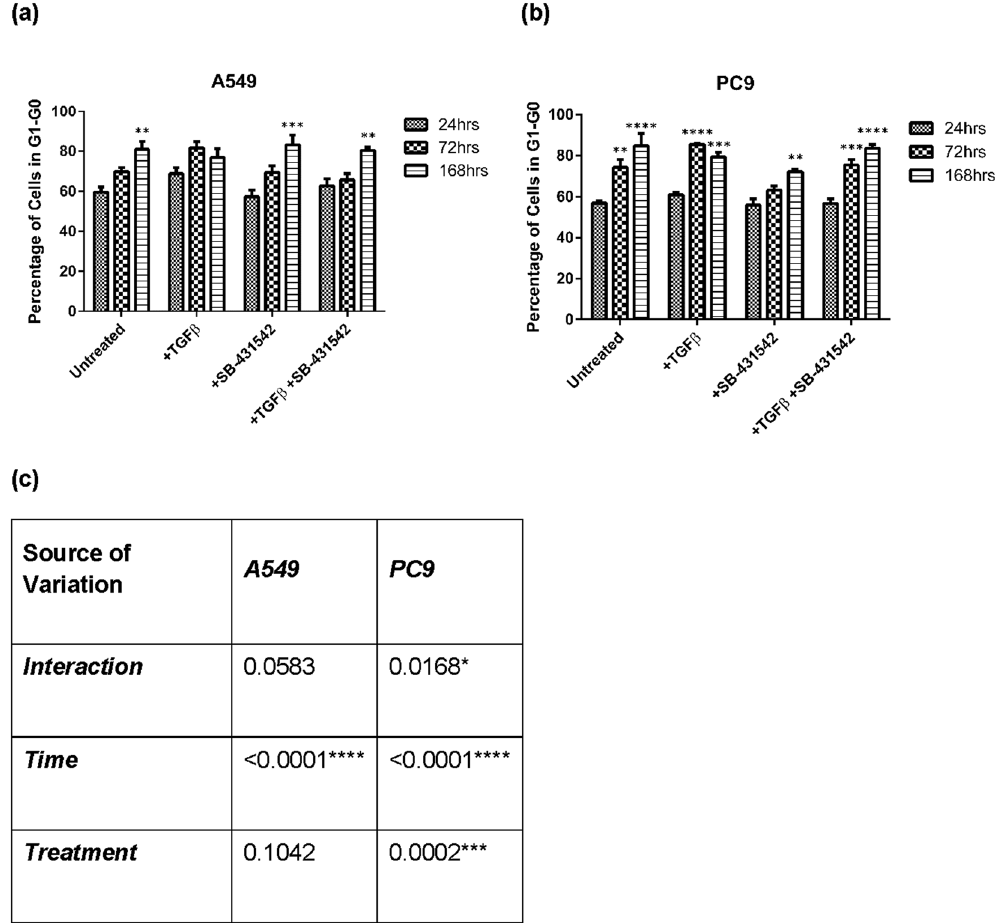
Figure 5. A549 and PC9 cells exit the cell cycle regardless of treatment with TGF β or SB-431542. The graph reflects the percentage of ( a ) A549 or ( b ) PC9 cell populations in G 0 -G 1 phase of the cell cycle at 24, 72, and 168 hours following treatment. Significance was determined using an unpaired t-test comparing the 72 and 168 hour time points individually to the 24 hour time point of the same treatment. ( c ) A two-way ANOVA was utilized to determine the significance of treatment and/or time point reflective of the percentage of cells in the G 0 -G 1 phase of the cell